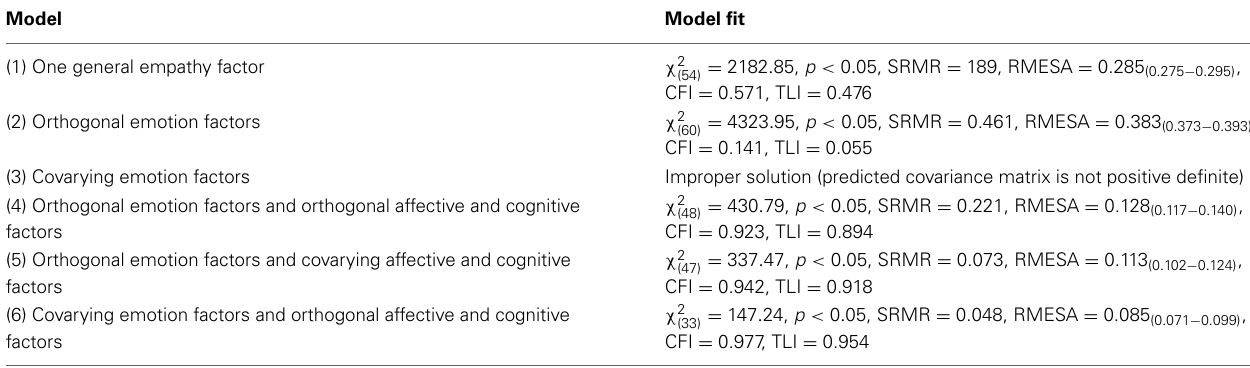
Table 4 | Measurement model fit.